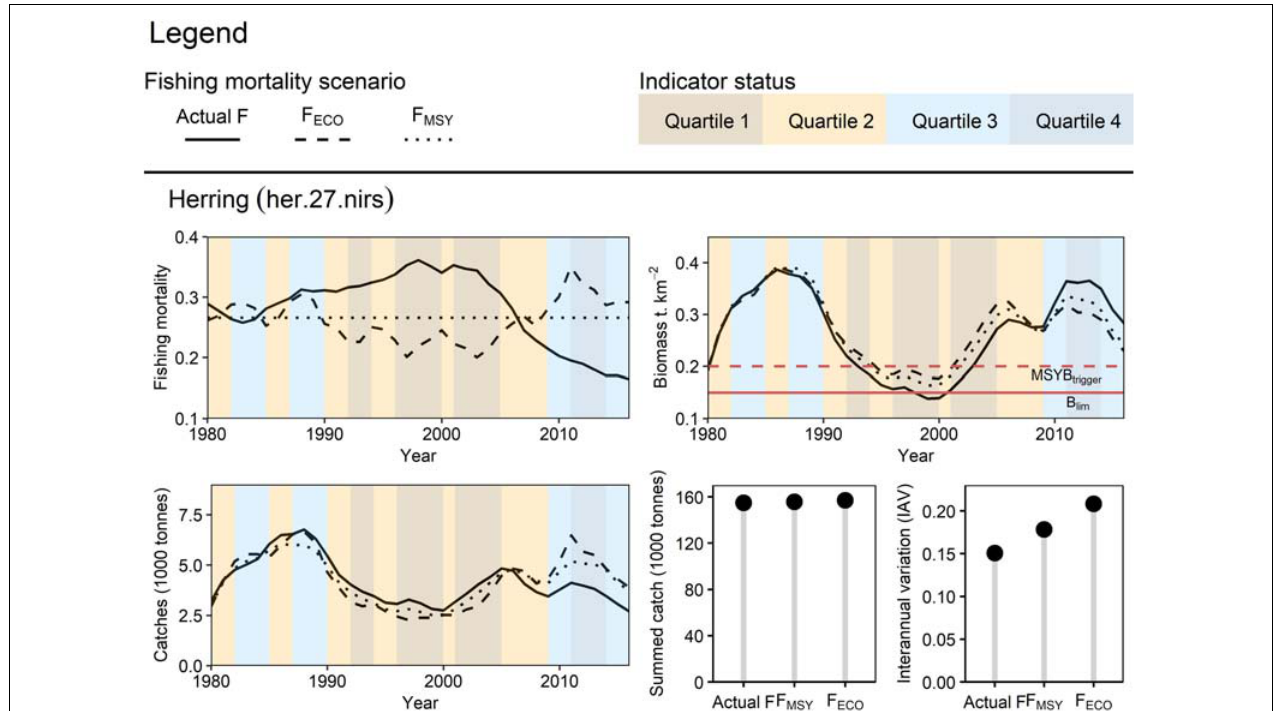
FIGURE 6 | Retrospective application of F ECO for Irish Sea herring: Three fishing mortality scenarios were prepared to simulate Irish Sea herring dynamics from 1980 to 2016. F ECO was retrospectively calculated based on the condition of the large zooplankton indicator. The different fishing mortality trends were applied to herring in the EwE model to simulate their effect on the stock’s biomass and catch (trend, total yield, and interannual